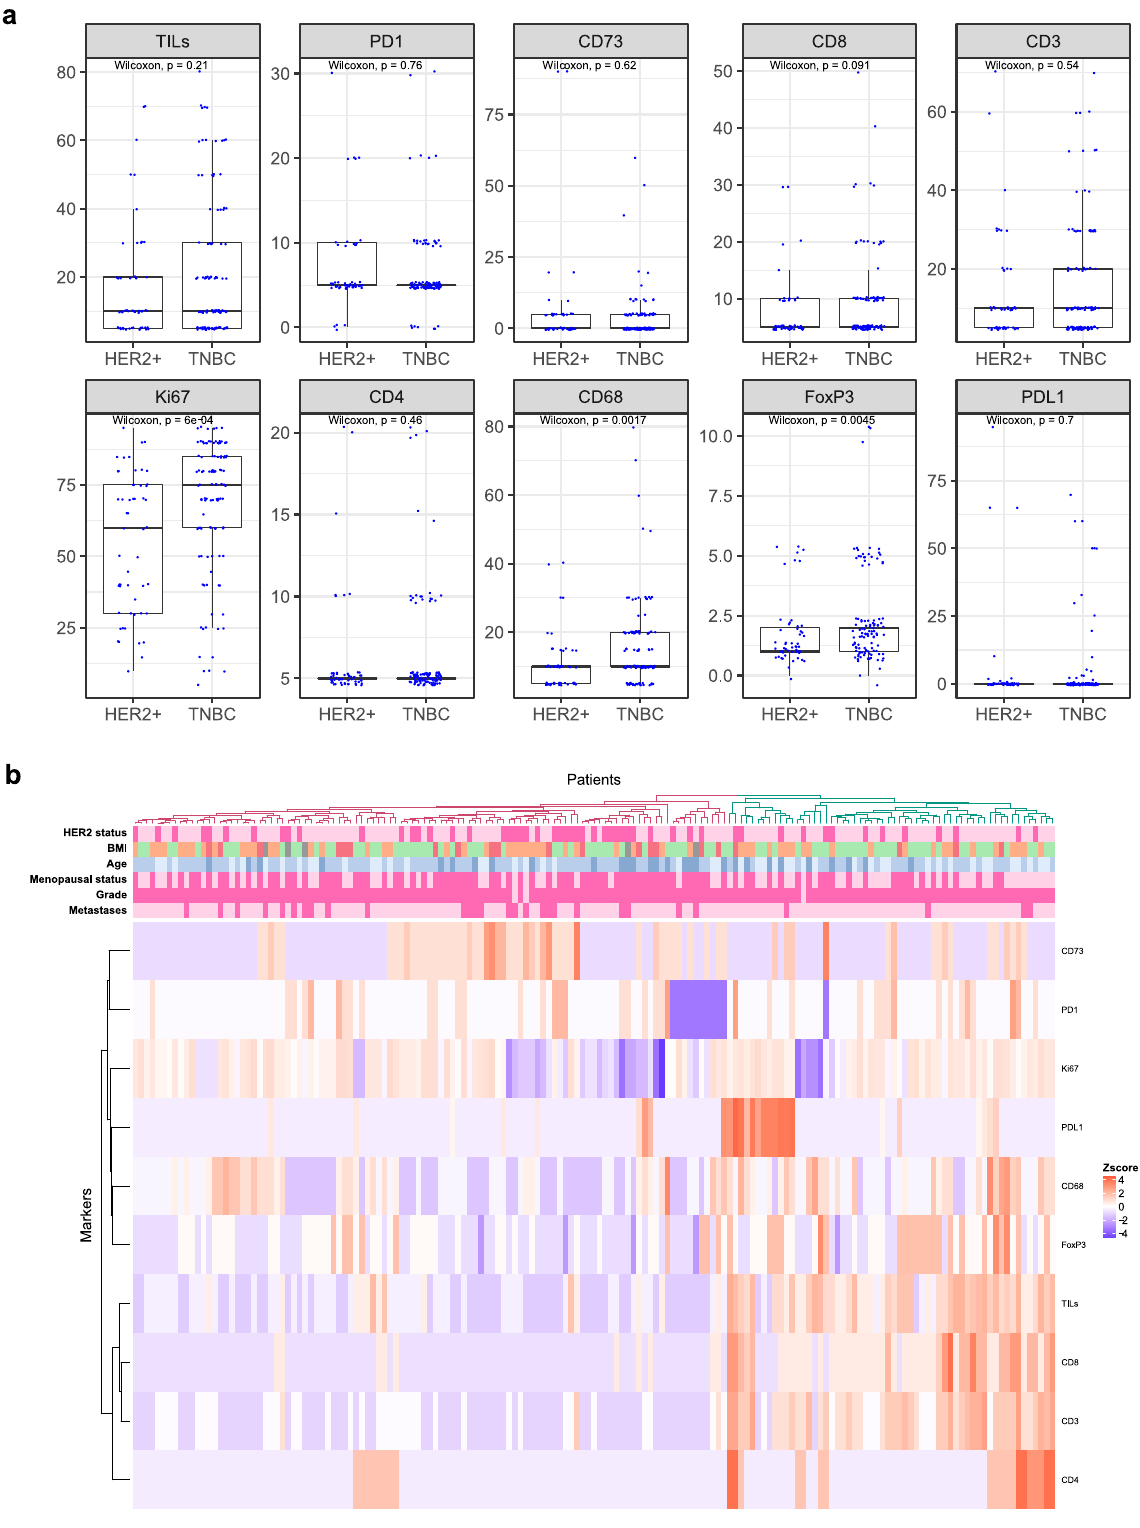
Body mass index did not correlate with sTIL (Supplementary Table 3), but patients with a high BMI had a signi fi cant higher expression of CD73 ( ρ = 0.202, p = 0.036). No associations between immune parameters and tumor size were found (Supplementary Table 5). However an association was